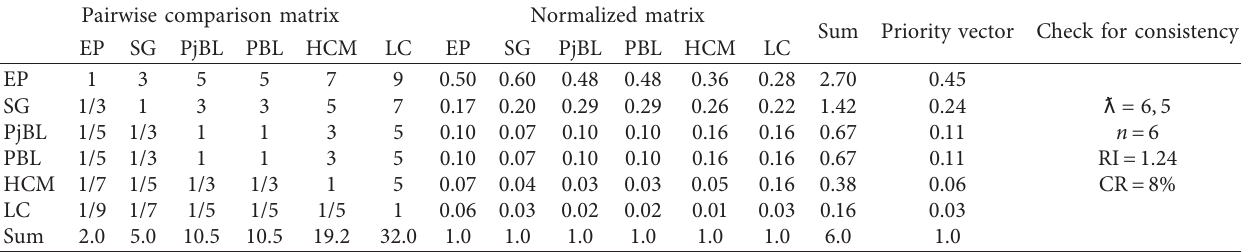
Table 9: Pairwise comparison matrix of learning strategies with respect to the criterion “SS1. Communication (French, English, negotiation).”